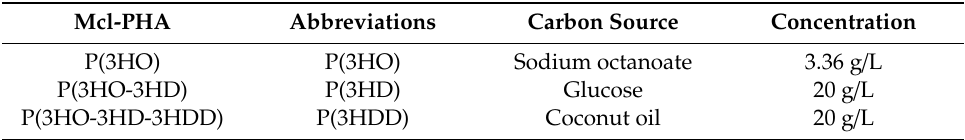
Table 1. Produced mcl-PHAs with the related carbon